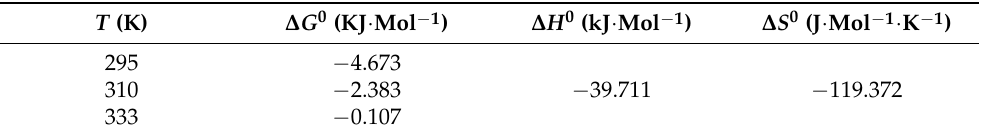
Figure 7. Linear plots of ( a ) ln K d versus C e and ( b ) ln K 0 versus 1000/T for RBBR adsorption retained by UPA( θ ) powders. Table 4. Thermodynamic parameters of RBBR adsorption retained by UPA( θ ) powders.